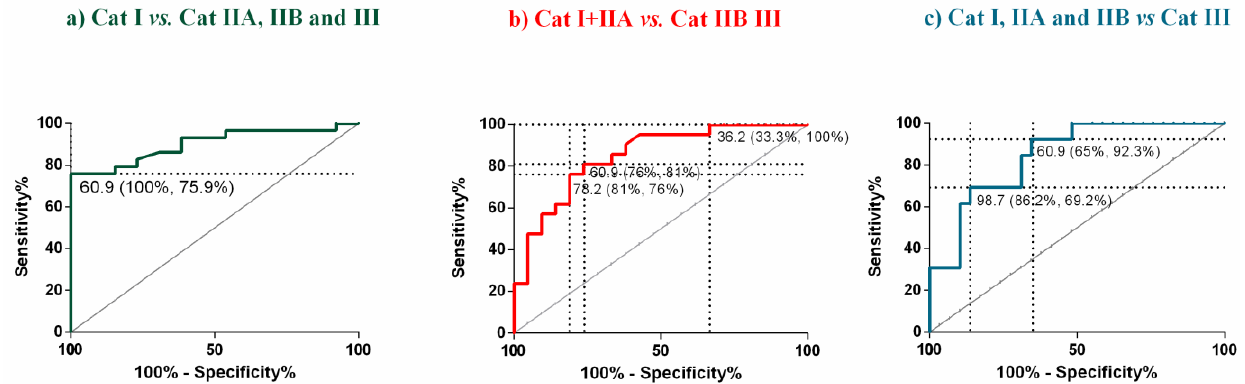
Figure 4. Receiver operating characteristic curves (ROC) of type III collagen for differentiation of the following: ( a ) healthy mares (category I endometrium—Cat I) from mares with endometrial degenerative/fibrotic lesions (Cat IIA, IIB, and III); ( b ) Cat I + IIA endometrium from IIB + III endometrium; ( c ) severe endometriosis (Cat III) from all the other endometrial categories. Cut-off values are expressed in ng/mL (specificity, sensitivity).